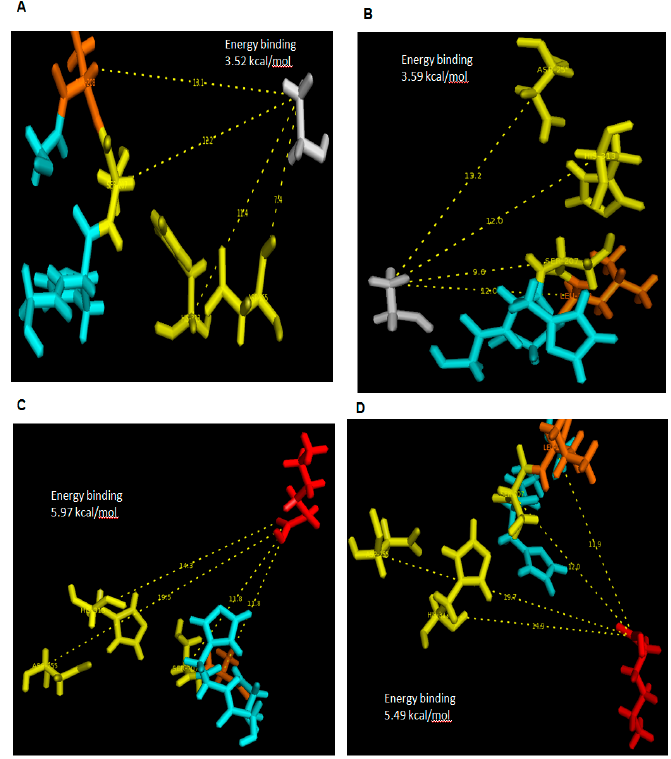
Figure 7. Docking with substrates ethanol and hexanoic ester showing distance with catalytic residues, Ser-207, Asp-255 and His-313. ( A , C ) referred to L208A docked with ethanol (grey) and hexanoic acid (red) while ( B , D ) showed WT AMS8 lipase docked with ethanol and hexanoic acid. Ethyl hexanoate was identified in stick colored in red, all catalytic residues in yellow, mutated or non-mutated Leu-208 in orange (with re-orientated side chain) and surrounding residues of GXSXG motifs (Gly-205, His-206, Gly-209) were identified in turquoise.